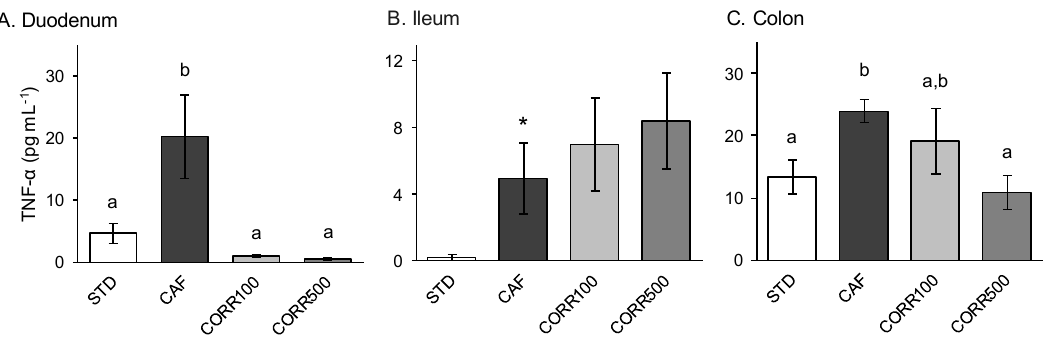
Figure 5. The effect of the GSPE treatment on the local inflammation of small and large intestines in diet-induced obese rats. TNF- α levels were determined from the basolateral media from the Ussing chamber after 30 min of incubation. Values represent mean ± SEM; n = 8–10. Different letters indicate statistically significant differences between groups ( p < 0.05); ANOVA test followed by Tukey’s HSD test when variances were equal and Dunnett’s T3 test when they were not. *Significant statistical differences with respect to the STD group; two-sided Student’s t -test.